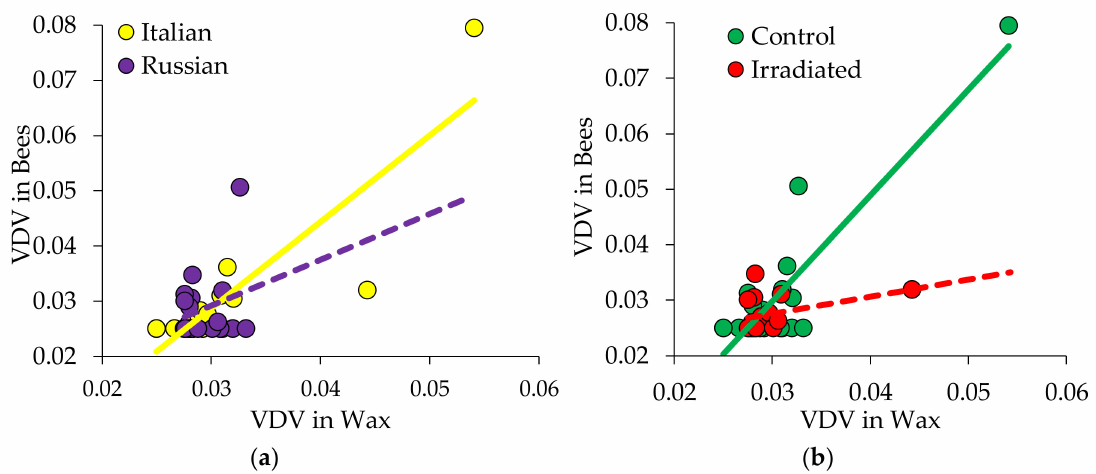
Figure 7. VDV-1 levels were positively correlated for newly emerged bees and wax collected from the same comb for samples from: ( a ) Italian colonies (yellow, solid line), but not for samples from Russian colonies (purple, dashed line), and ( b ) colonies with control (green, solid line) combs, but not from colonies with irradiated (red, dashed line)